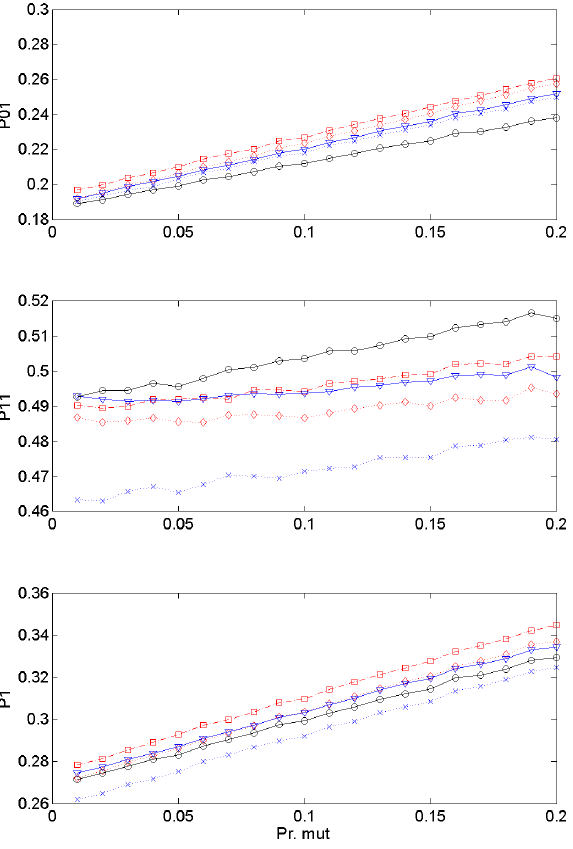
Figure 12. Transition probabilities and marginal distribution along with changing the crossover probability with the condition that the mutation is processed only if the candidate value is 1. See Eq. (16) for